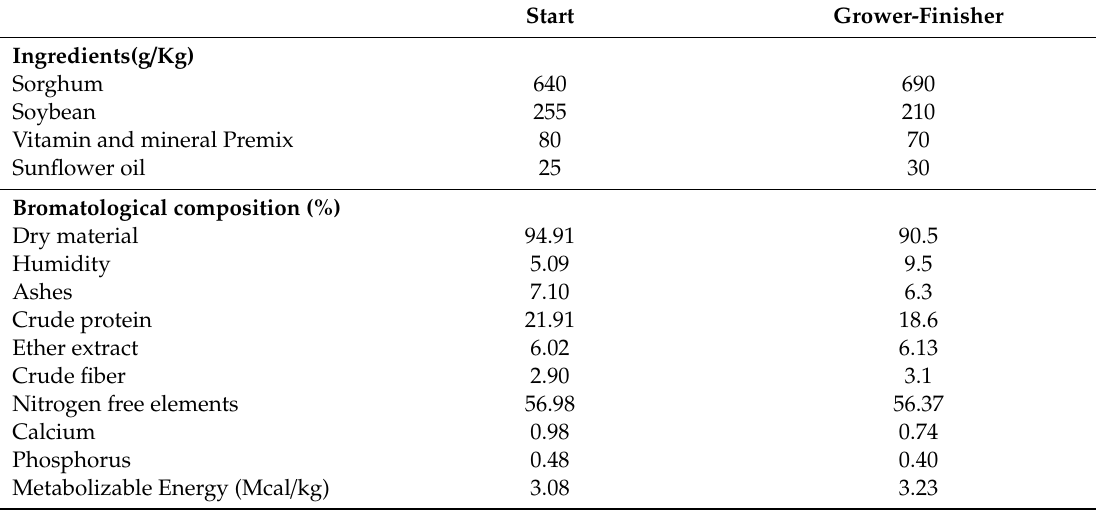
Table 1. Ingredients and bromatological composition of the basal diets administered to broilers. Start